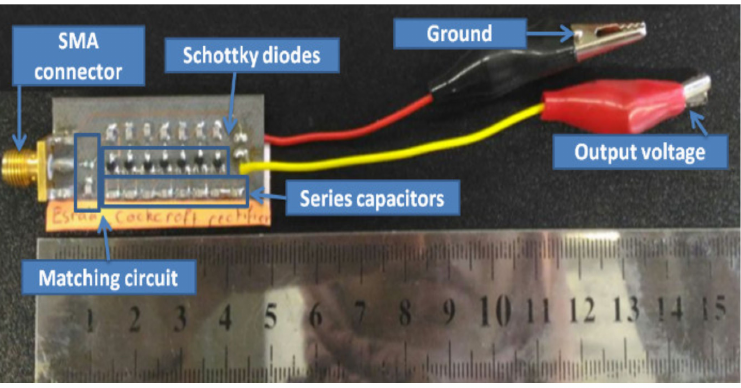
Figure 17. The fabricated Cockcroft–Walton voltage multiplier rectifier.